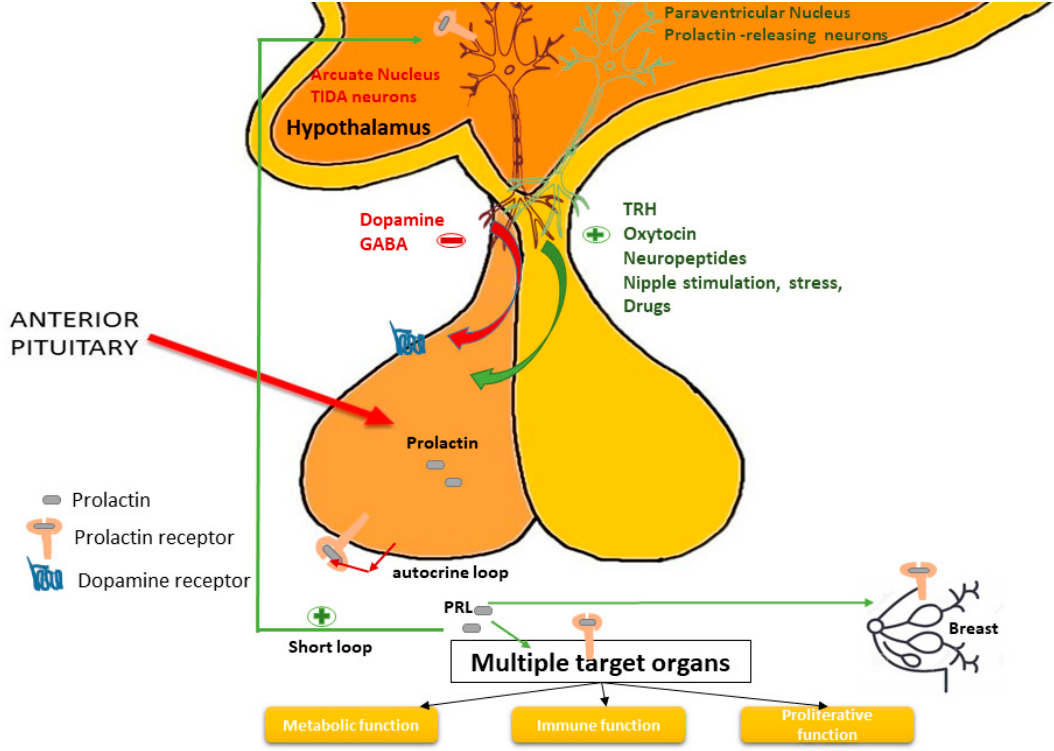
Figure 2. Control of prolactin production and secretion. Prolactin controls its own secretion through a short loop, stimulating TIDA cells and in the own lactotroph cell by an autocrine loop.